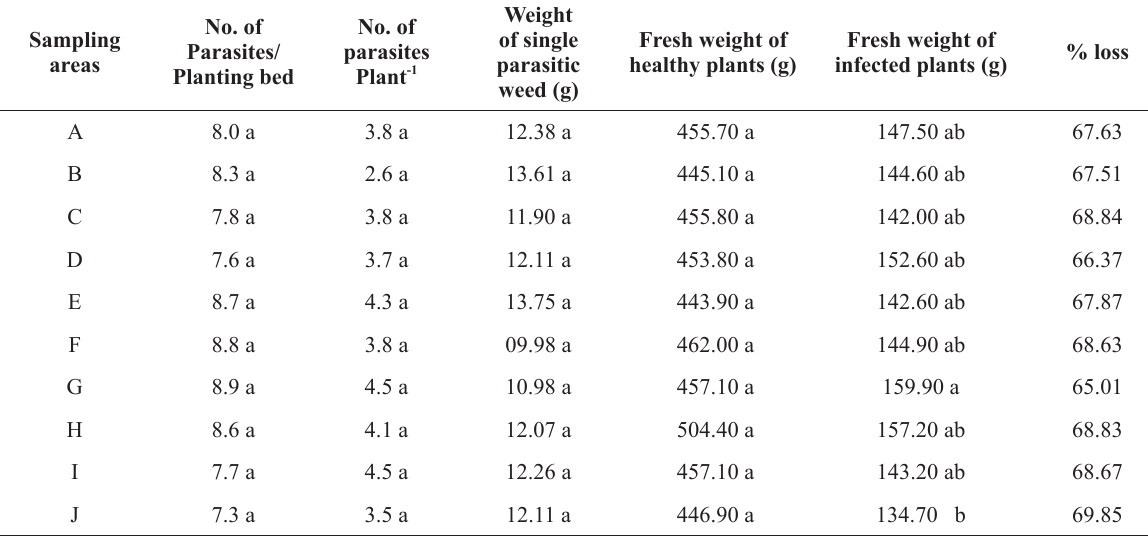
Occurrence and loss of Orobanche aegyptiaca in Potohar plateau of Pakistan. Sampling